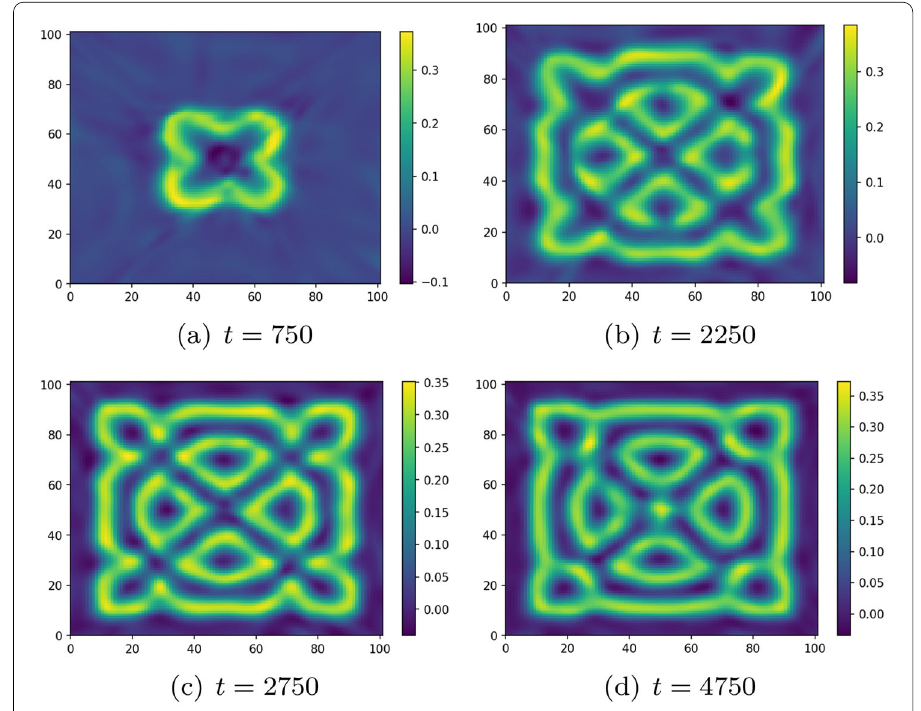
Fig. 9 Example of Zebrafishpatterns . The parameters used in the (3) are F = 0 . 035 and K = 0 . 060. The times shown are: t = 750 , 2250 , 2750 ,